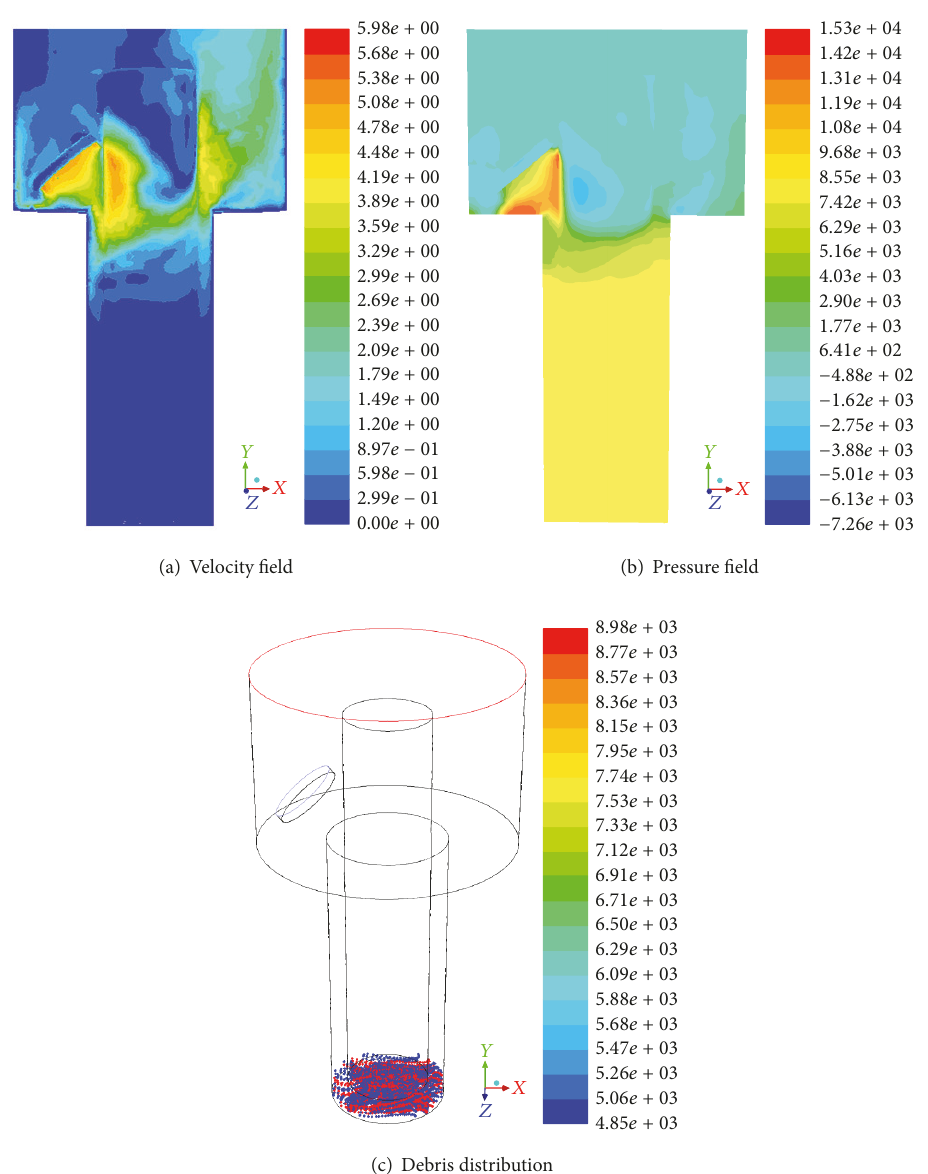
Figure 11: Schematics of gap flow field with flushing at 5m/s and 3.5 mm deep